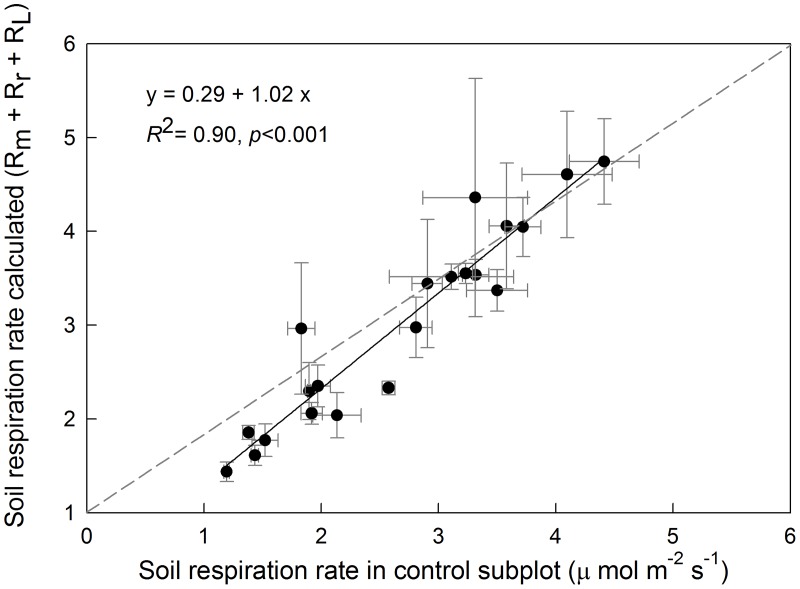
Relationship between soil respriation rate in the control subplots and the caluculated value as the sum of the different components. Bars represent standard errors. Dark gray line is 1:1 line and black line is fitting line.